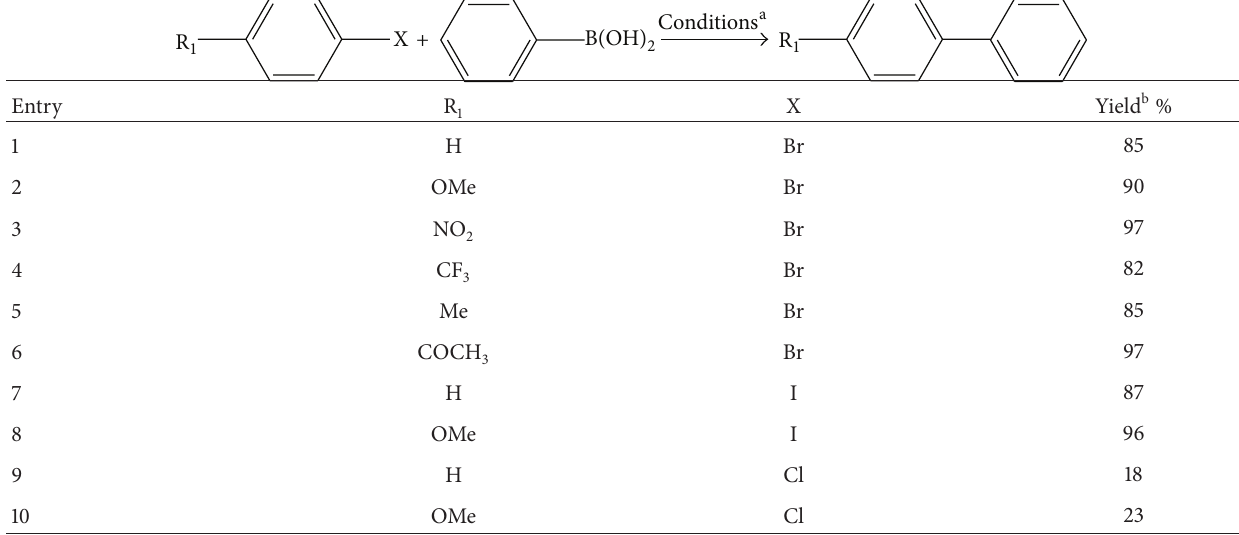
Table 1: Microwave-promoted Suzuki coupling of aryl halides with phenylboronic acid catalyzed by XL-QPPd nanoparticles.